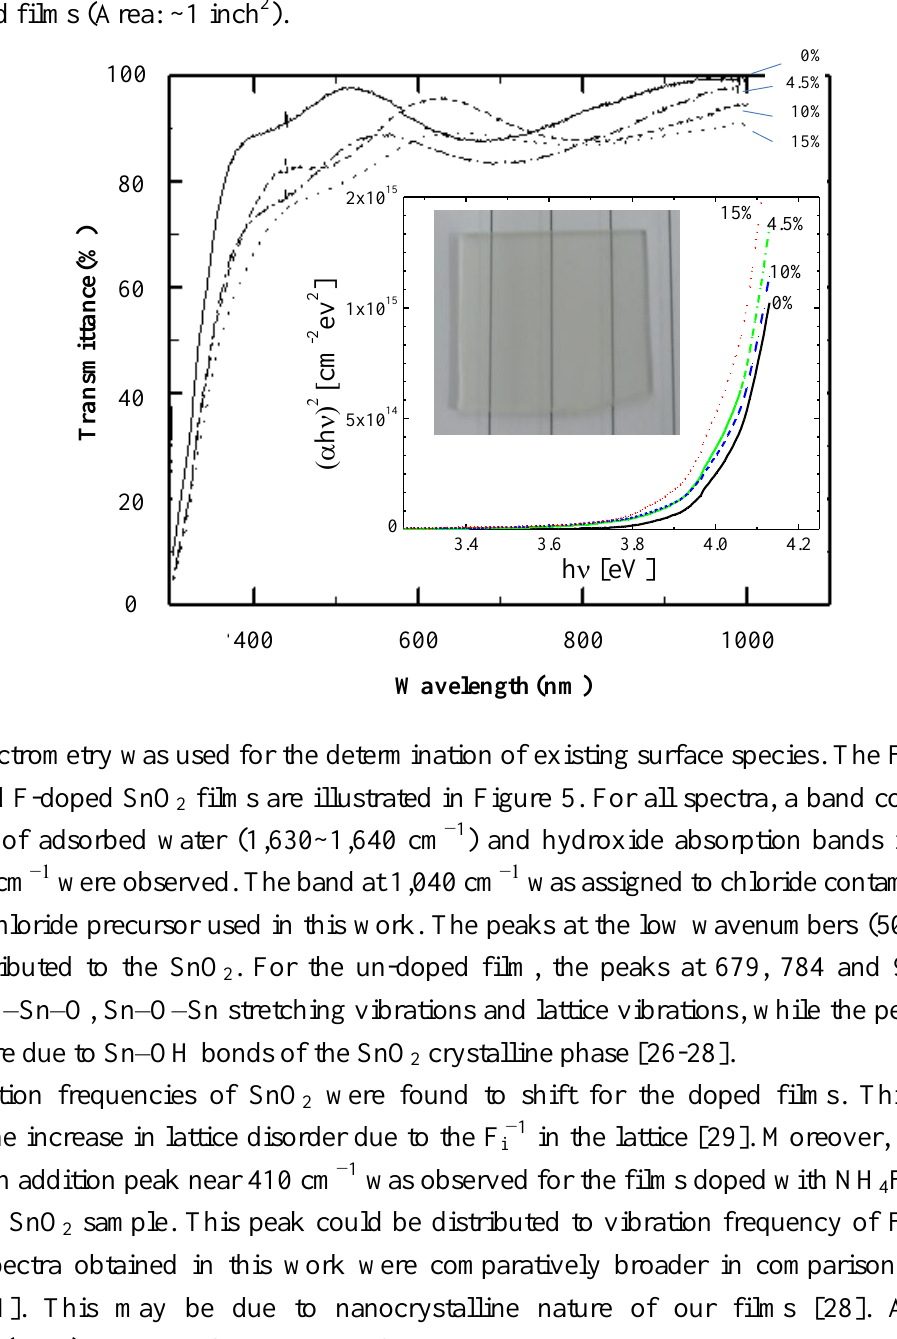
films deposited under different NH 2